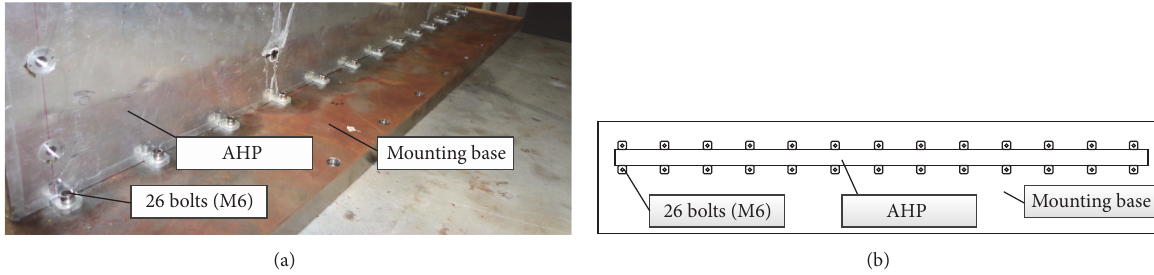
Figure 1: (a) The AHP connected to a mounting base via multiple bolts. (b) A graphic illustration of the bolted